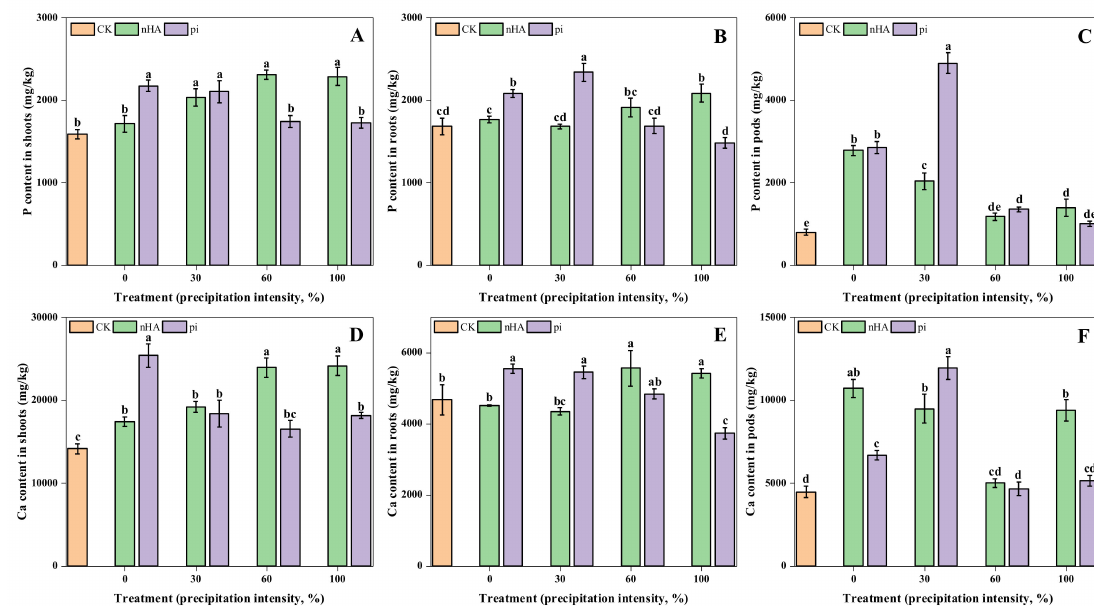
Figure 4. The content of P and Ca in soybean shoots ( A , D , respectively), roots ( B , E , respectively), and pods ( C , F , respectively) treated with nHA or pi (under simulated precipitation scenario). Error bars correspond to the standard errors of the means. Values of each nutrient content that are followed by different letters are significantly different at p < 0.05.